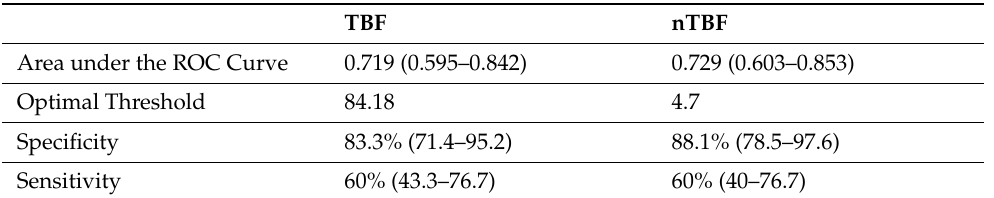
Table 3. ROC analysis data comparing maximum TBF and maximum normalized nTBF in groups of malignant wildtype and IDH1-mutant gliomas.